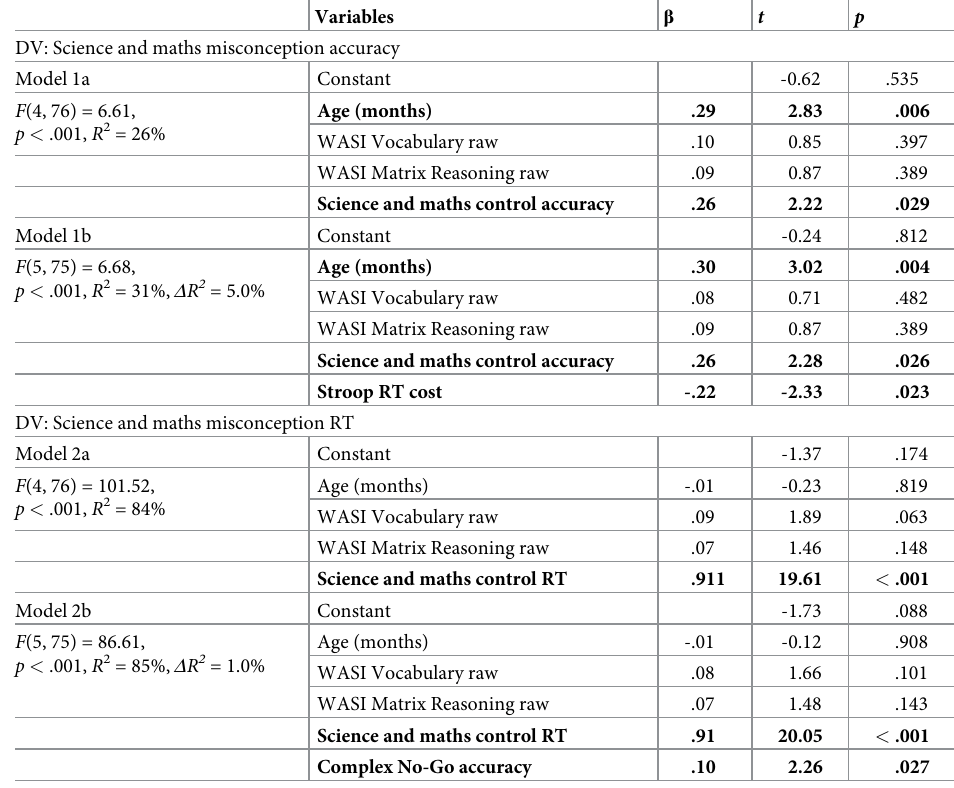
Table 4. Regression models for science and maths combined. Variables β